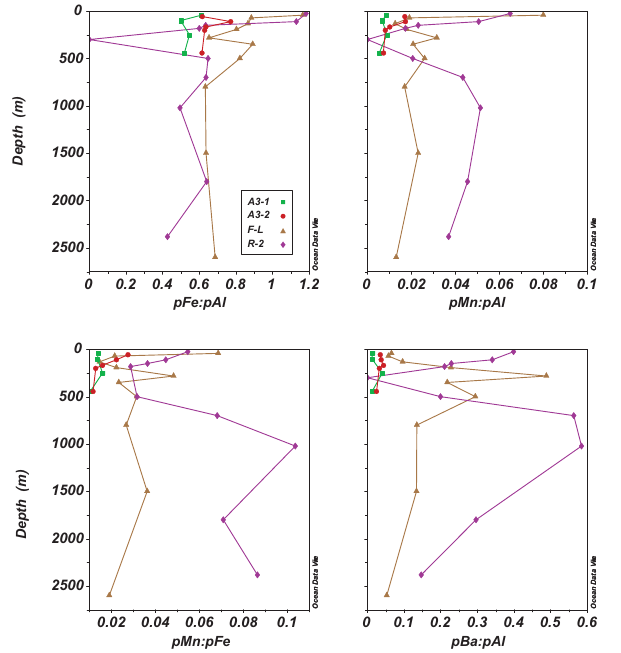
Figure 6. Molar ratio of pMn:pAl of suspended particles versus depth, separated by station type. Vertical lines represent the median molar ratios within Kerguelen Island basalts (Gautier et al., 1990) (black), authigenic Kerguelen Plateau sediments (red) and station R-2 authigenic sediments